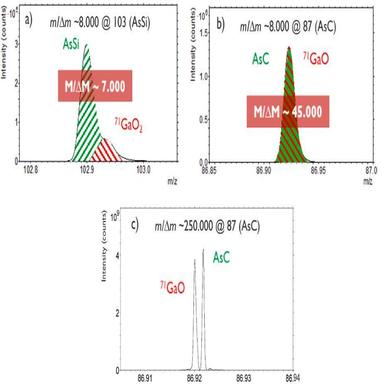
a) and b) ToF-SIMS mass spectra (acquired at m/Δm ~8000) of mass 103 and mass 87, respectively, corresponding to the AsSi− and AsC− signals and the mass resolutions needed to fully resolve the mass interferences with GaOx − based ions. c) Orbitrap™-SIMS mass spectrum (acquired at m/Δm ~250000) of mass 87 showing complete separation of the AsC− and 71GaO− signals.